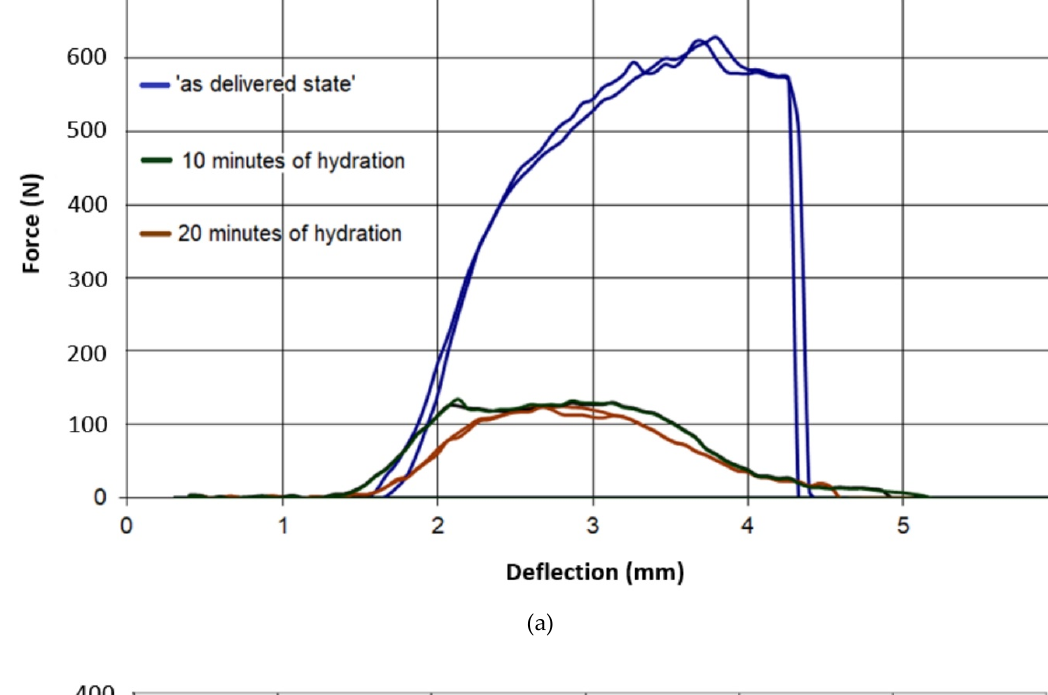
Figure 7. Force –deflection curves of the tested specimens of type A, ( a ) parallel to the sheet production direction, ( b ) perpendicular to sheet production direction.